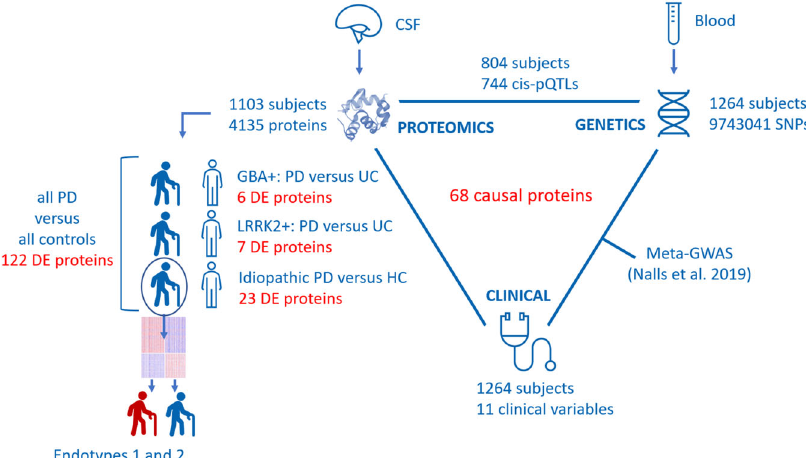
Fig. 1 Study analytical design. 1103 subjects were analyzed with SomaScan for 4135 unique proteins in CSF. The comparison between GBA + PD patients and GBA + unaffected controls (UC) retrieved six differentially expressed (DE) proteins. The comparison between LRRK2 + PD patients and LRRK2 + UC retrieved seven DE proteins. The comparison between idiopathic PD patients and HC non-mutation carriers retrieved 23 DE proteins. Patients and controls were also combined and compared, which retrieved 122 DE proteins. Idiopathic PD patients were further analyzed, and two endotypes were identi fi ed based on CSF proteomics. 1264 subjects were sequenced genome wide to detect a total of 9743041 SNPs. For the 804 patients that had both genomic and proteomic data, a pQTL analysis was performed that identi fi ed 744 unique proteins with a signi fi cant cis-pQTL. The pQTLs combined with a meta GWAS for PD performed by Nalls et al. 70 , led to the proposal of 68 unique CSF proteins presumed to be causal for